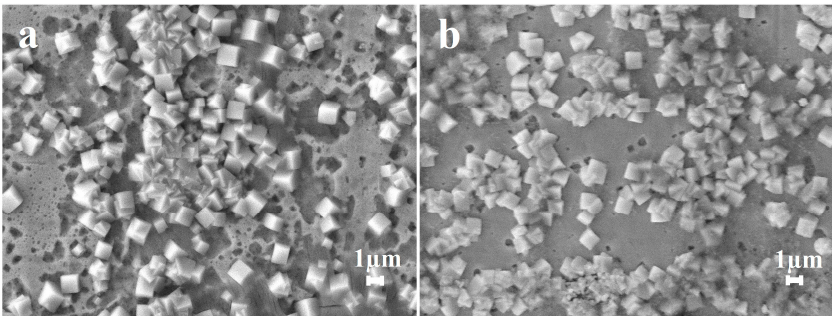
Figure 3. SEM images of the surface of electrodes modified with copper particles ( a ) before scanning and ( b ) after 100 cycles in an alkaline ethanol solution.